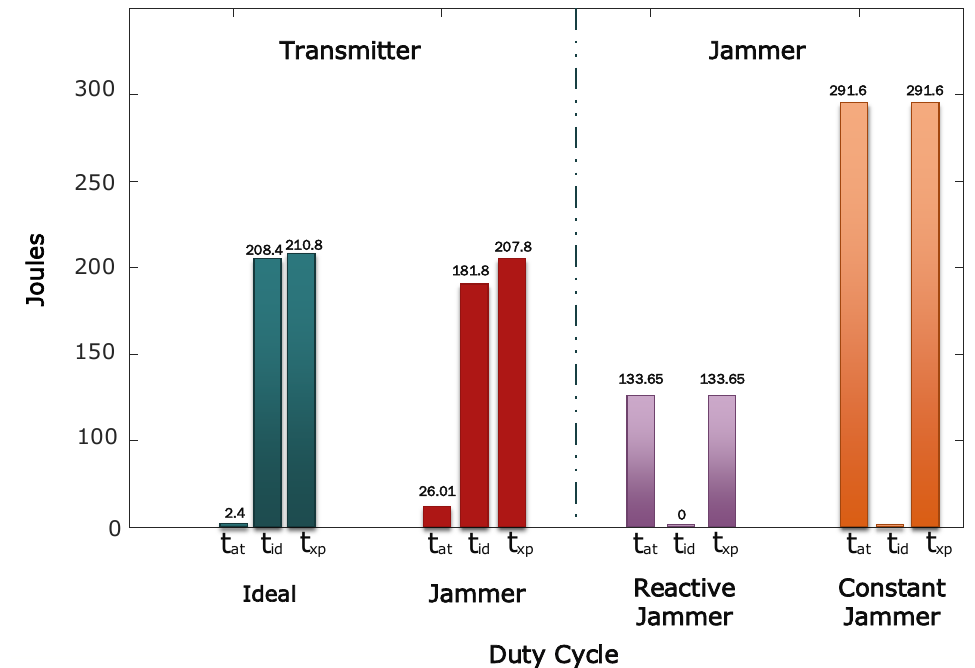
Figure 16. Bar plot of the energy consumption for the transmitter in the ideal and jammer scenario for the different states of the duty cycle. Additionally, the energy consumption of both jammers is